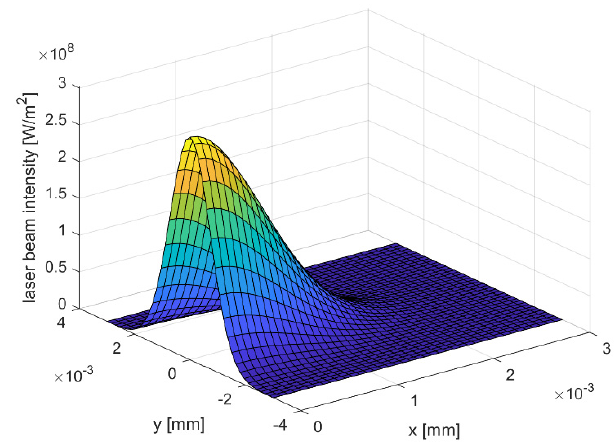
Figure 2. Laser beam intensity for spot size s = 3 mm.